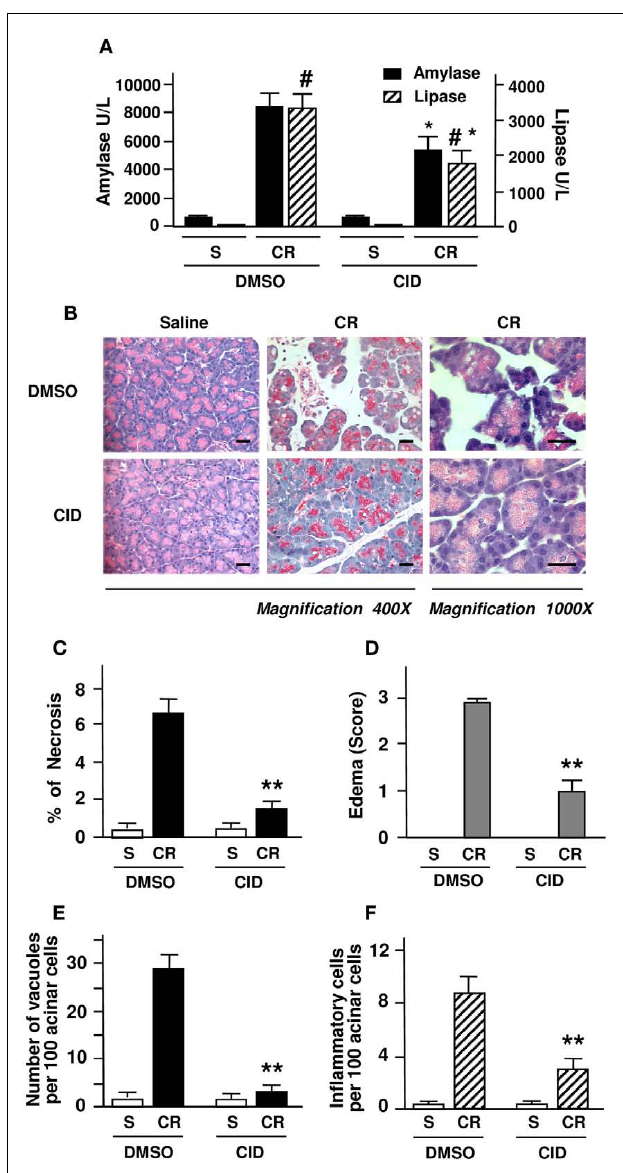
FIGURE 4 | PKD/PKD1 inhibition by CID755673 ameliorates necrosis and other pancreatitis parameters in cerulein-induced pancreatitis. Rats received intraperitoneal (IP) injection of CID755673 (CID, 15mg/kg) or same volume of vehicle DMSO. At 60min after the pretreatment, pancreatitis was induced by four hourly IP injections of cerulein (CR), as described in Section “Experimental Procedures.” Control rats received saline (S).The blood and pancreas were harvested in 4h after the first injection of cerulein for the following measurements. (A) Serum